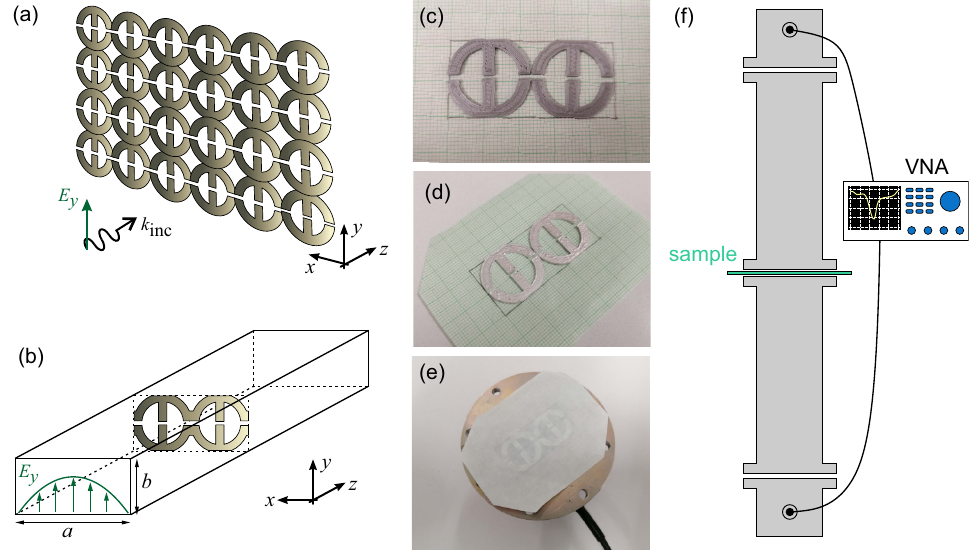
Figure 1. ( a ) Periodic metasurface illuminated with a normally incident plane wave of E y polarization. ( b ) Two unit cells fitted in a rectangular metallic waveguide. ( c ) 3D-printed unit cells using a PLA filament. ( d ) Structure after coating with a conductive silver paste. ( e ) Test fitting of the structure under study on the flange of the waveguide-to-coax adapter. The unit cells are lightweight and can be simply glued on a piece of paper and inserted at any junction between waveguide segments. ( f ) Measurement setup including a vector network analyzer allowing to measure reflection (S 11 ) and transmission (S 21 )